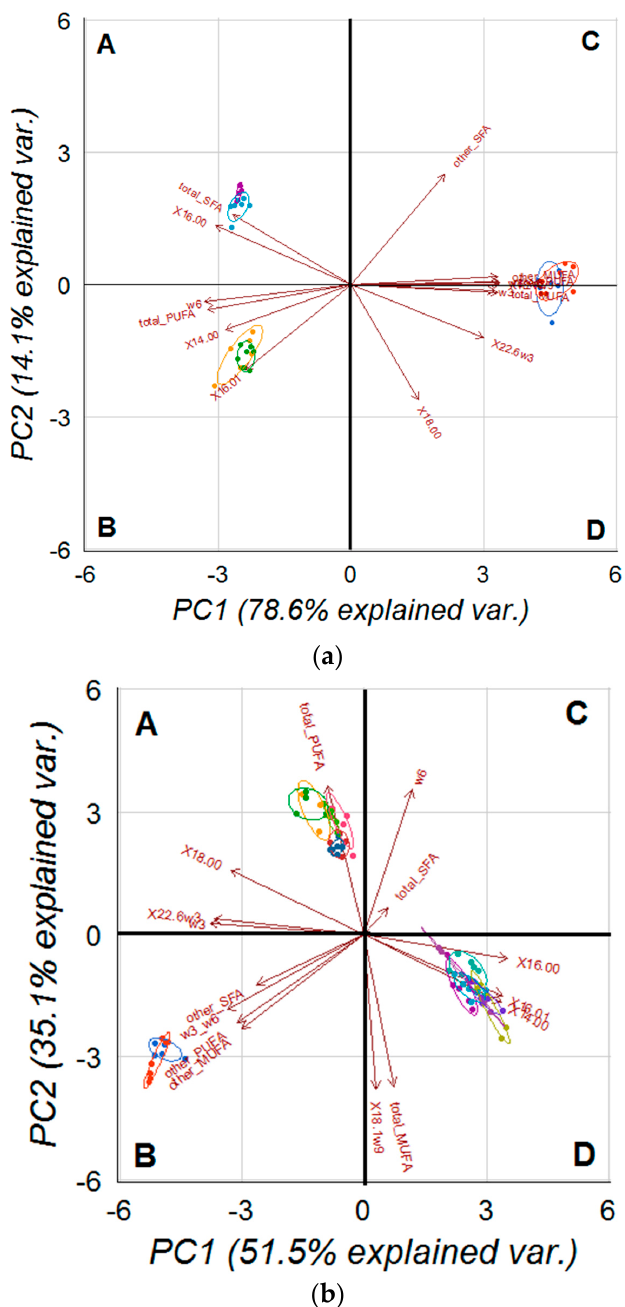
Figure 1. Loading plot of the first and second principal components of the pooled FAME and component’s score vectors of liver, erythrocytes, heart, kidney, subcutaneous and visceral fat and brain from Wistar rats fed normal (CG) and D. vlkianum -biomass supplemented (MG) diets. Legends: ( a ) brain (CG) ( ● ), brain (MG) ( ● ), liver (CG) ( ● ), liver (MG) ( ● ), RBC (CG) ( ● ) and RBC (MG) ( ● ); ( b ) brain (CG) ( ● ), brain (MG) ( ● ), heart (CG) ( ● ), heart (MG) ( ● ), kidney (CG) ( ● ), kidney (MG) ( ● ), liver (CG) ( ● ), liver (MG) ( ● ), RBC (CG) ( ● ), RBC (MG) ( ● ), subcutaneous fat (CG) ( ● ), subcutaneous fat (MG) ( ● ), visceral fat (CG) ( ● ), visceral fat (MG) ( ● ).